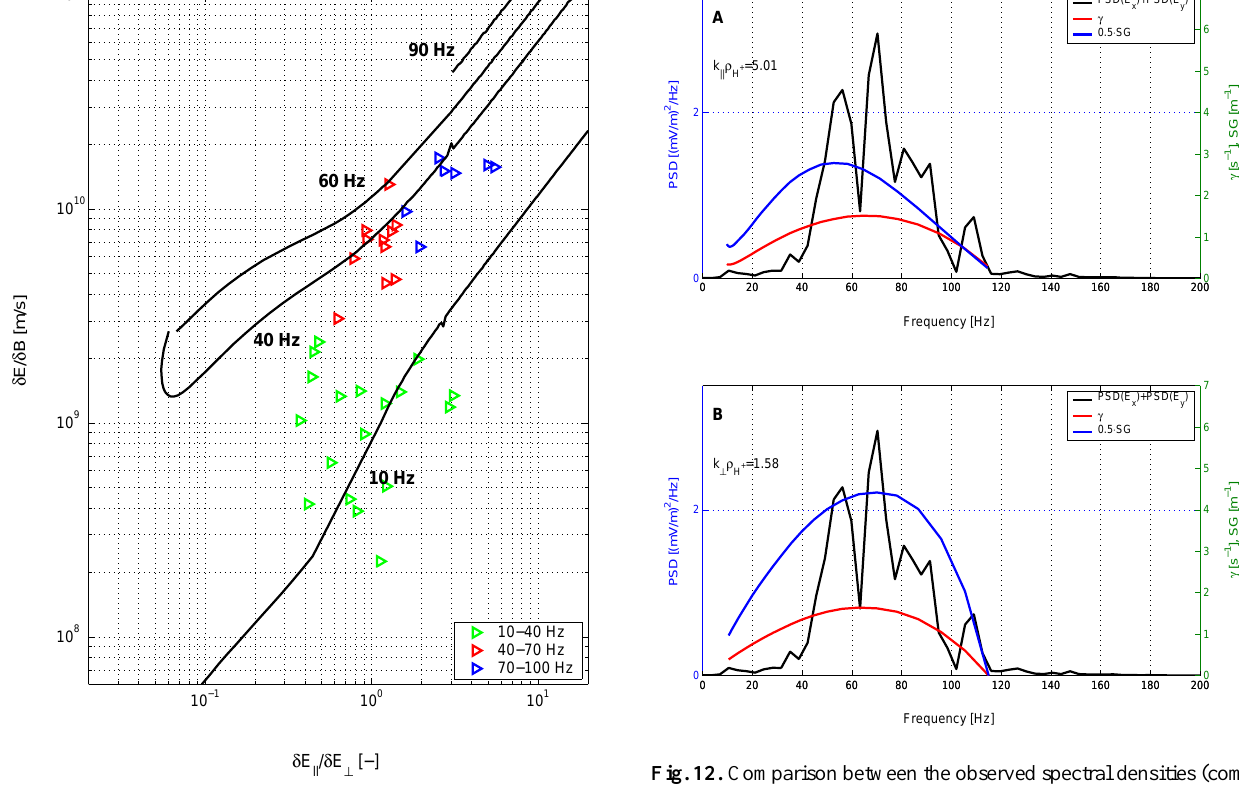
Fig. 12. Comparison between the observed spectral densities (com- puted using the electric field), and the temporal and spatial growth rates predicted by theory. In panel (A) we plot the growth rates ver- sus frequency keeping k || fixed ( k k ρ H + = 5 . 01 ) . In panel (B) we let k ⊥ be constant ( k ⊥ ρ H + = 1 . 58 )